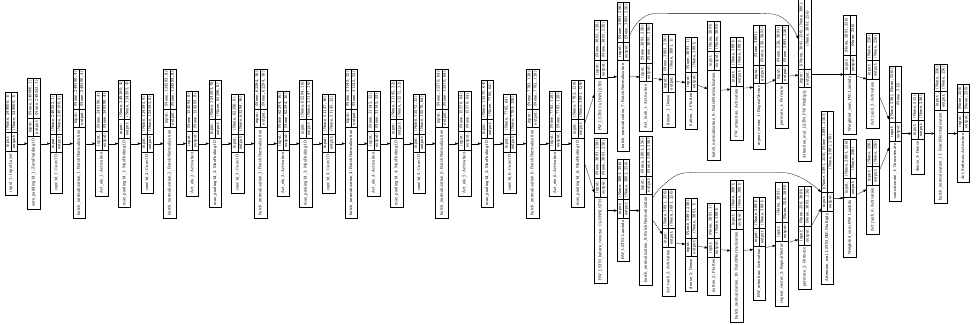
Figure 29: Network for desynchronized ASCAD v2.